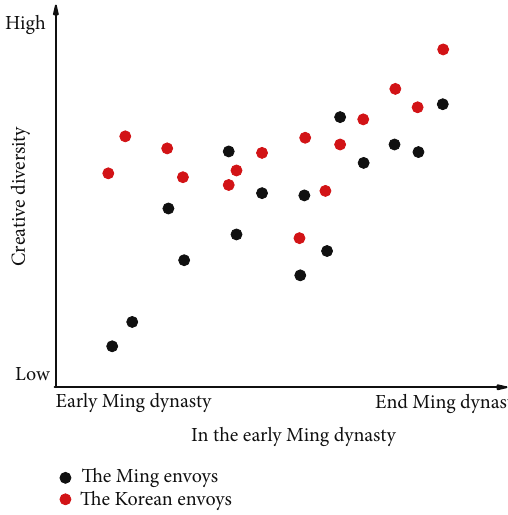
Figure 8: The comparison of the creative diversity of Ming and Korean